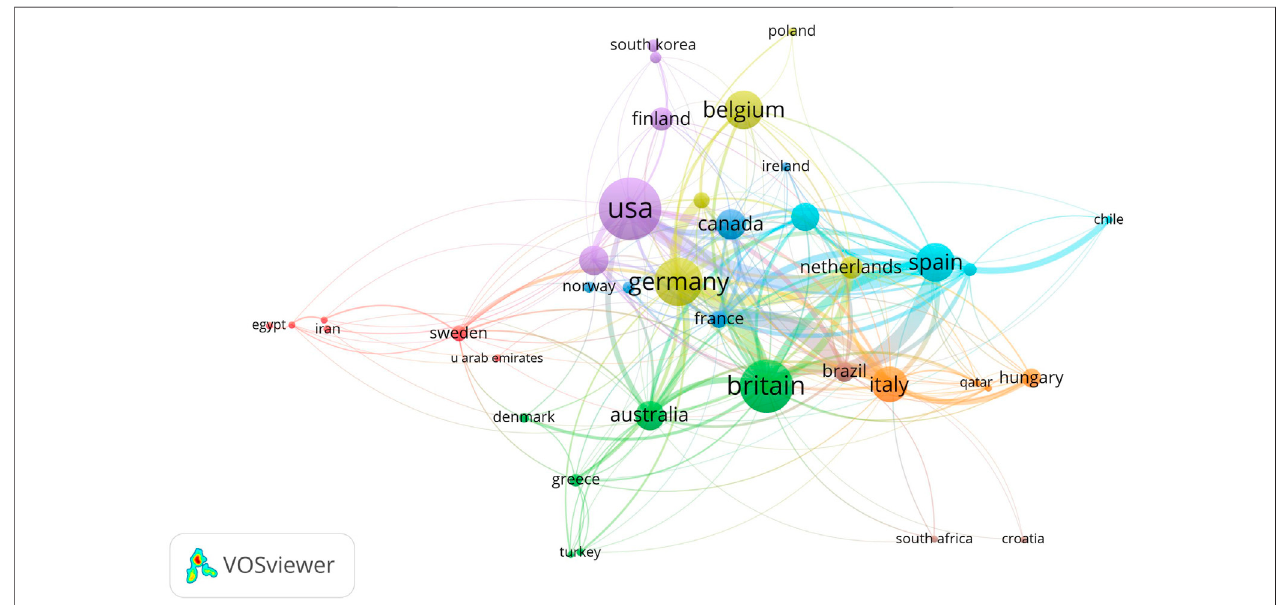
FIGURE 2 | Cooperation network of the countries in the research of WBVT.